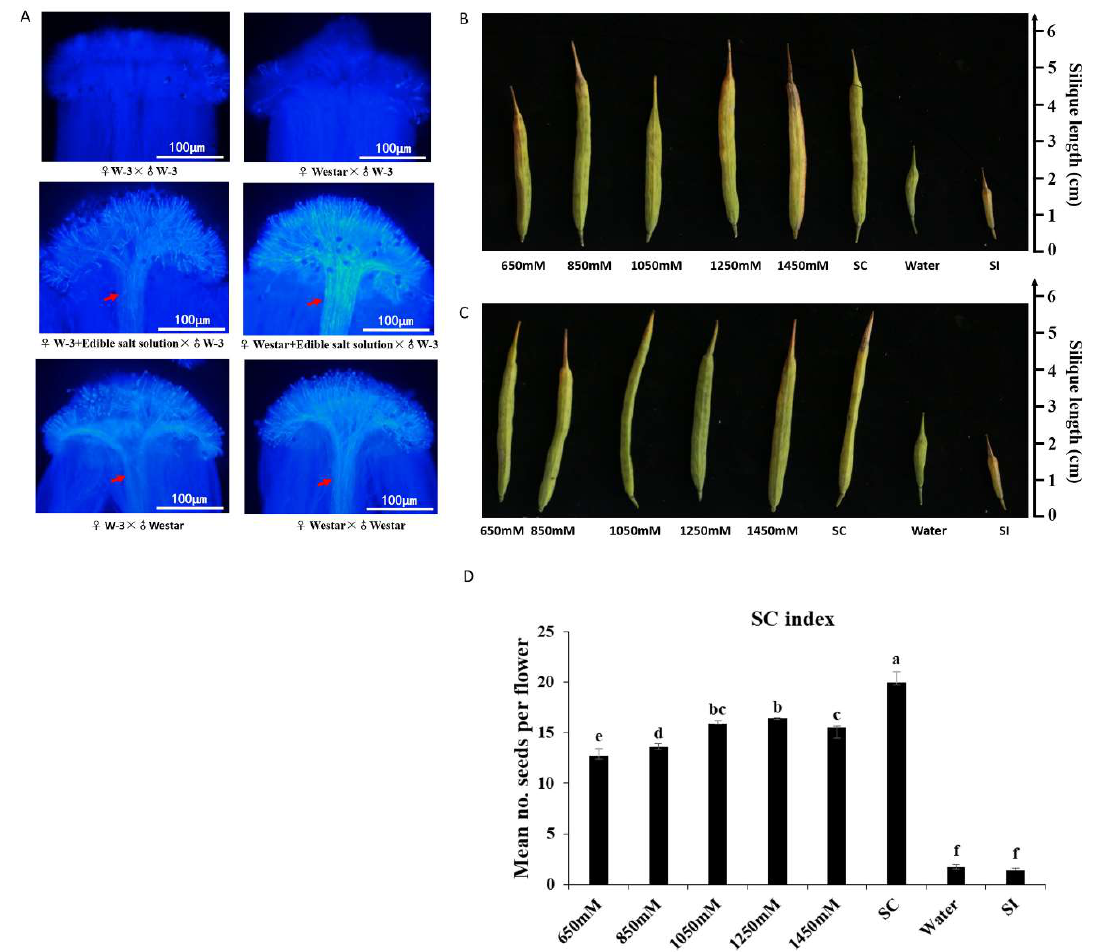
Figure 1. Breakdown of self-incompatibility by edible salt solution treatment in “W-3” and “Westar”. Pollination with “Westar” pollen grains was taken as a self-compatibility control (SC); self-incompatibility control was pollination with “W-3” pollen grains (SI), and pollination with “W-3” pollen grains after water treatment (Water); “Westar” flowers were emasculated one day before flower opening to avoid any contamination by self-pollen grains; concentrations of the salt solution were 650 mM, 850 mM, 1050 mM, 1250 mM, and 1450 mM. ( A ) Aniline blue assays performed 16 h after pollination with incompatible “W-3” pollen grains, compatible “Westar” pollen grains, and incompatible “W-3” pollen grains after 1050 mM edible salt solution treatment on the stigmas of both “W-3” and “Westar”. Every treatment included at least six individual pistils. Red arrows indicate abundant pollen tubes; ( B ) mature pods developed from “W-3” pistils that pollinated with self-pollen grains after treatment with edible salt solutions; ( C ) mature pods developed from “Westar” pistils were pollinated with “W-3” pollen grains after edible salt solution treatment; and ( D ) Mean self-compatibility indexes of “W-3” after edible salt solution treatment and their statistic test by one-way ANOVA with Scheffe post hoc tests. The different letters represent means that are significantly different at p < 0.05; Error bars indicate standard deviation.